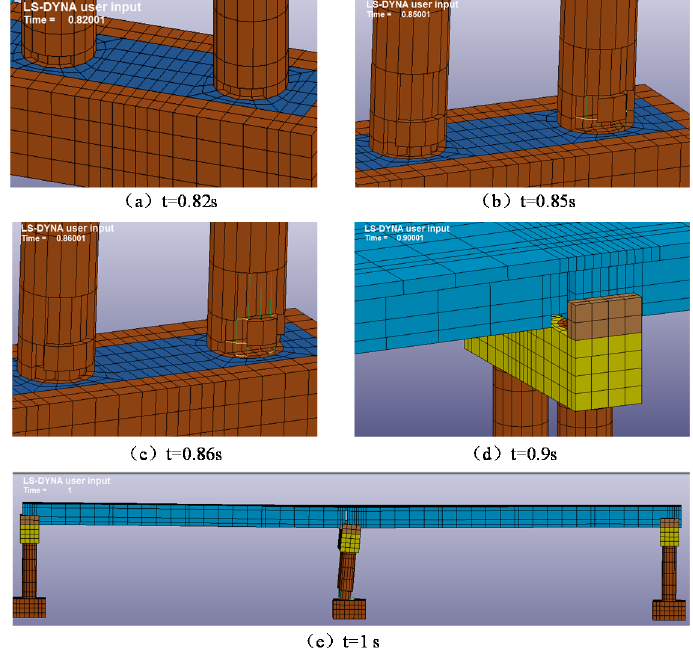
Figure 19. Longitudinal collapse mode of the CFVD system under the El Centro wave.